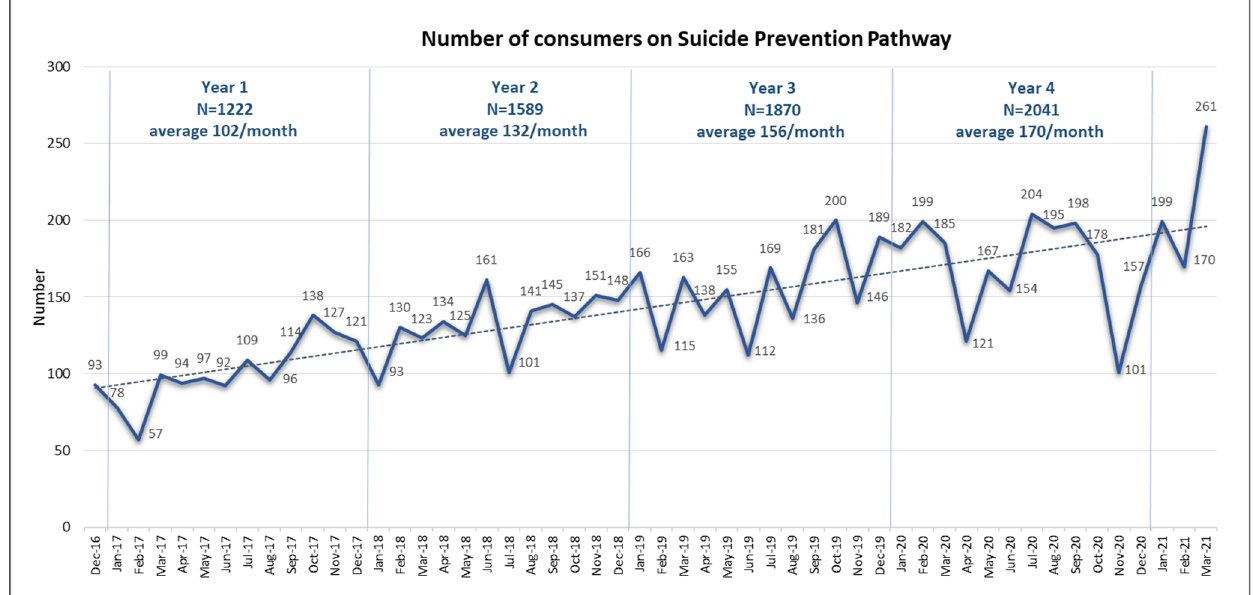
Figure 3. Numbers of consumers on Suicide Prevention Pathway at Gold Coast Mental Health and Specialist Services.